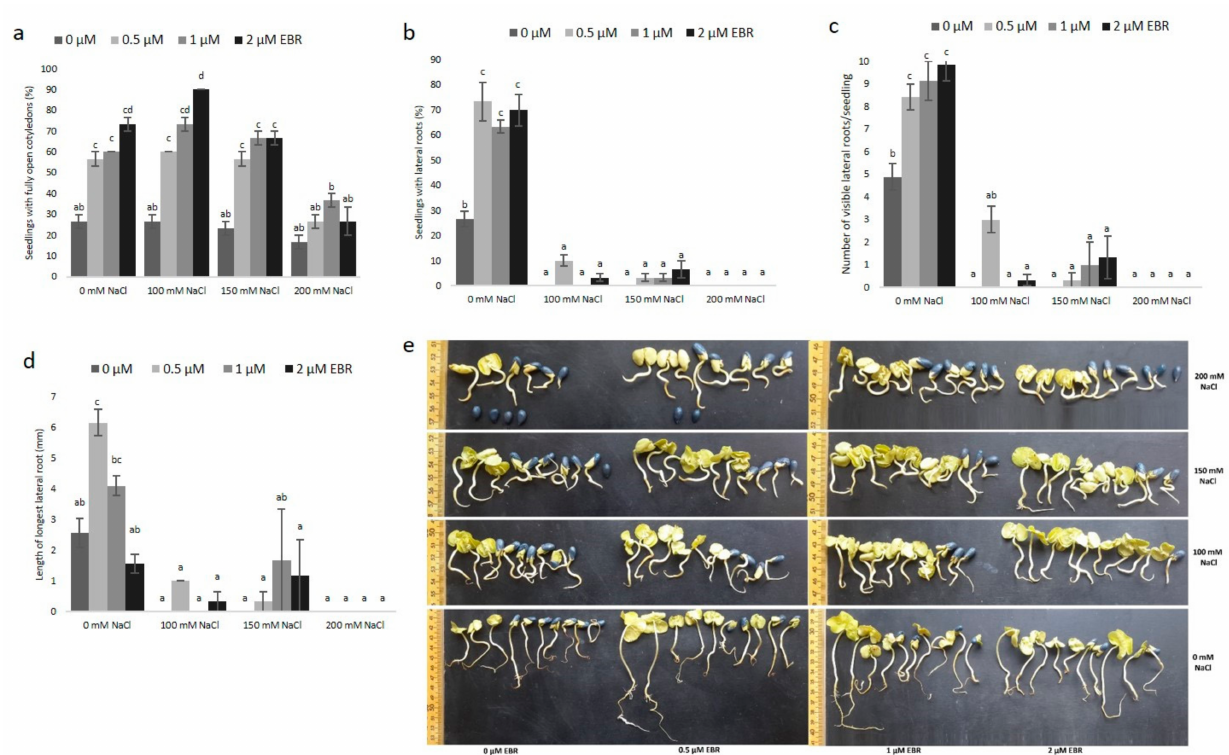
Figure 2. Cotyledon opening and lateral root formation under salt stress following pre-treatment of seeds with EBR. Percentage of seedlings with fully open cotyledons ( a ); percentage of seedlings with lateral roots ( b ); average number of visible lateral roots per seedling ( c ); average length of the longest lateral root from each seedling ( d ), and seedling phenotype ( e ), in response to 0, 0.5, 1 and 2 µ M concentrations of EBR under 0, 100, 150 and 200 mM NaCl were recorded on the 13th day from when seeds were put for germination. Error bars represent standard error (SE) of the mean for three replicates ( n = 30). Different letters above the bars indicate significant differences in two-way ANOVA ( p < 0.05) followed by Tukey’s post hoc